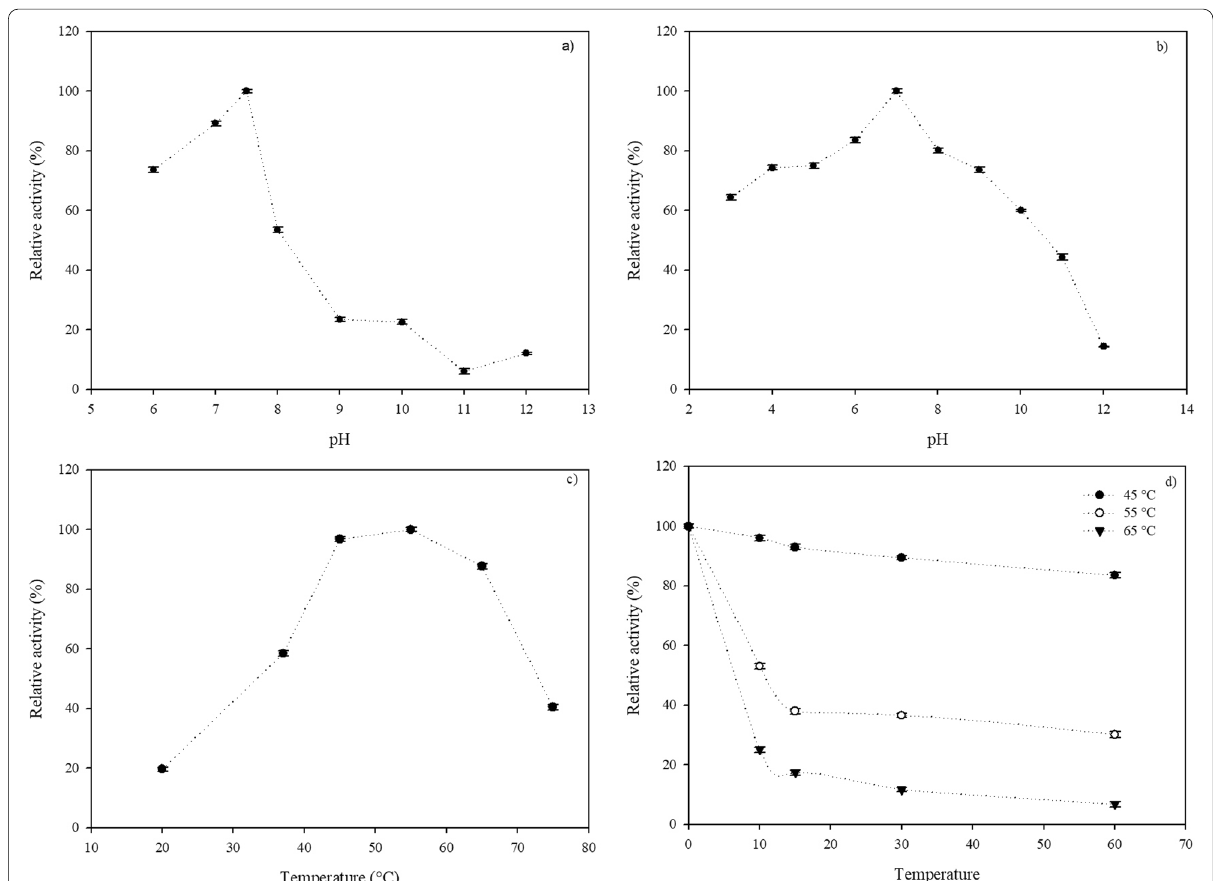
Fig. 4 Effect of temperature and pH on the activity of keratinase expressed by Pedobacter sp. 3.14.7; a effect of pH on keratinase activity; b pH stability of keratinase enzyme. The enzyme was pre‑incubated at different pH values for 1 h at 37 °C. Then, the residual activity was measured under standard assay conditions; c effect of temperature on keratinase activity; d thermal stability of keratinase enzyme. The enzyme was pre‑incubated at different temperatures and then the residual activity was determined under standard assay conditions.; values represent the means